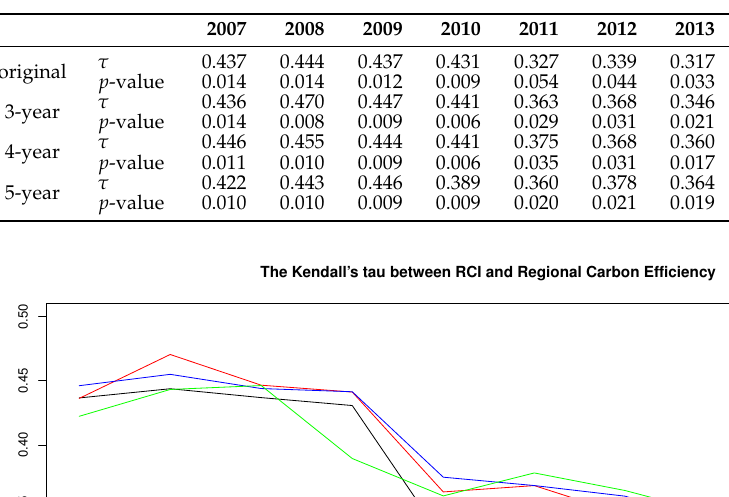
Table 9. The Kendall’s τ estimation between RCI and carbon efficiency for each year from 2007 to 2016.